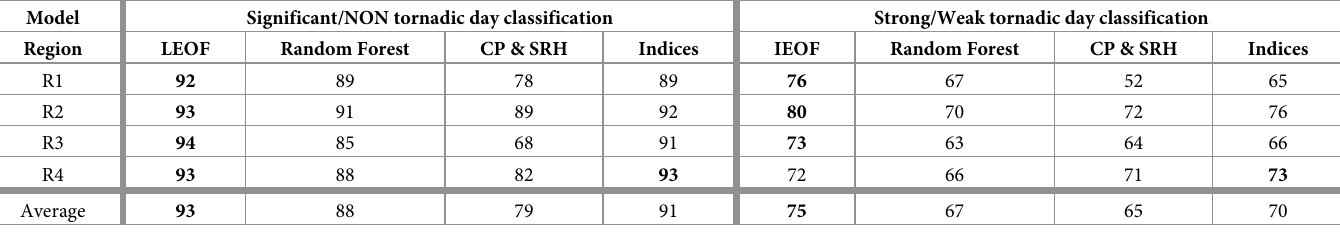
Table 7. Summary of the Monte Carlo leave-20%-out validation. Models comparison validating the LEOF and the IEOF models compared to the other competing mod- els (Random Forest, CP & SRH and Indices). Based on the receiver operating characteristic (ROC) from the Mote Carlo (MC) validation results, the table reports the area under the curve (AUC %) for the different models. The LEOF and the IEOF models have better AUC on average and over each region compared to the other models.